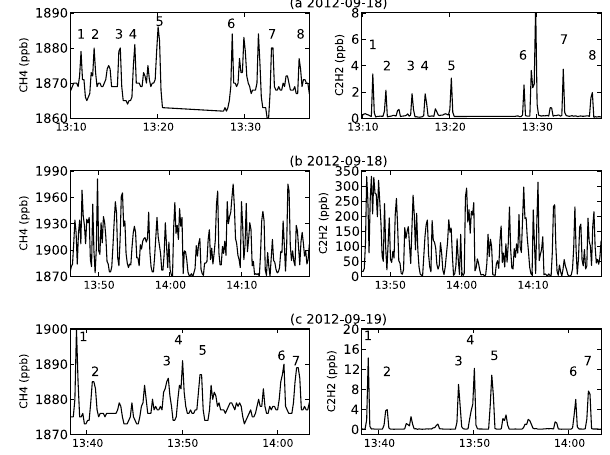
Figure 10. Concentrations of CH 4 and C 2 H 2 during the three tracer release episodes. Episode (a) : estimation of the whole plant emis- sion on 18 September with a south wind; the C 2 H 2 cylinder is lo- cated in A (see Fig. 1). Episode (b) : estimation of the degassing basin emissions on 18 September with a south wind; the C 2 H 2 cylinder is located in A. Episode (c) : estimation of the whole plant emissions on 19 September with a north wind; the C 2 H 2 cylinder is located in A. The numbers indicate the signals (peaks) that are used to calculate the CH 4